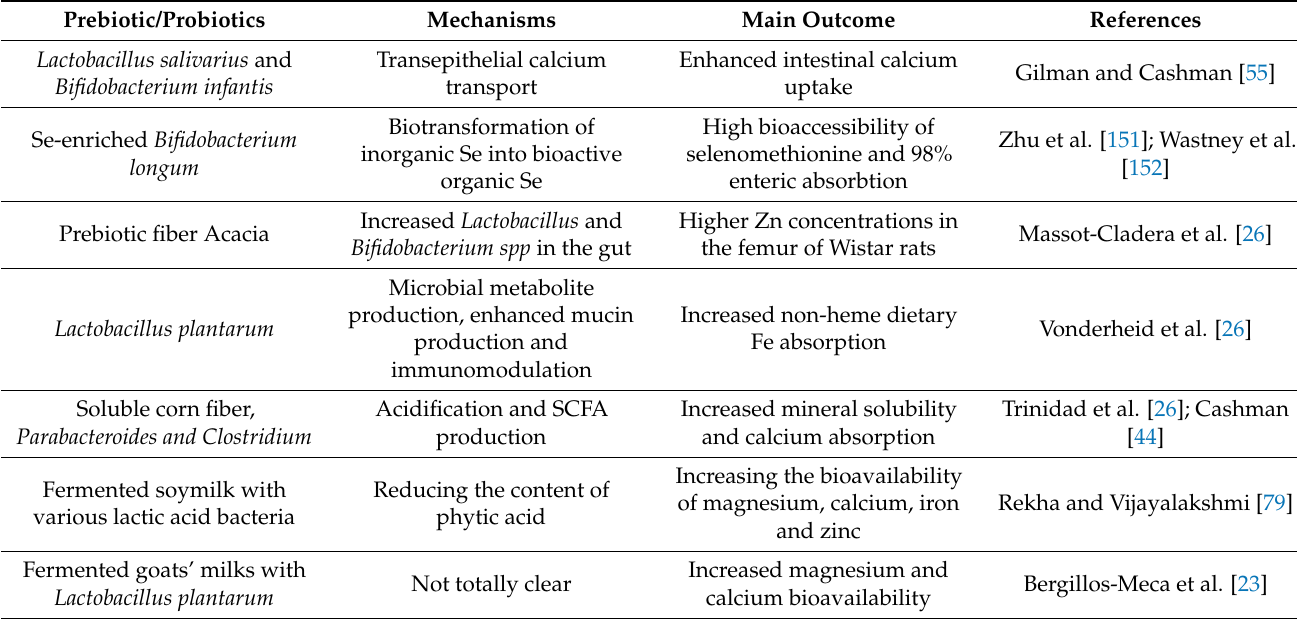
Table 2. The absorption, bioaccessibility, and bioavailability of essential minerals in relation to the gut microbiome.